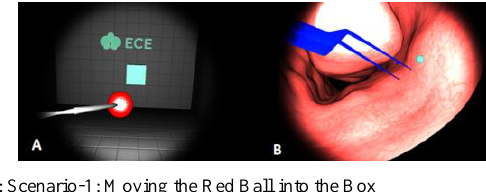
Figure 3. Scenarios for Experimental Study